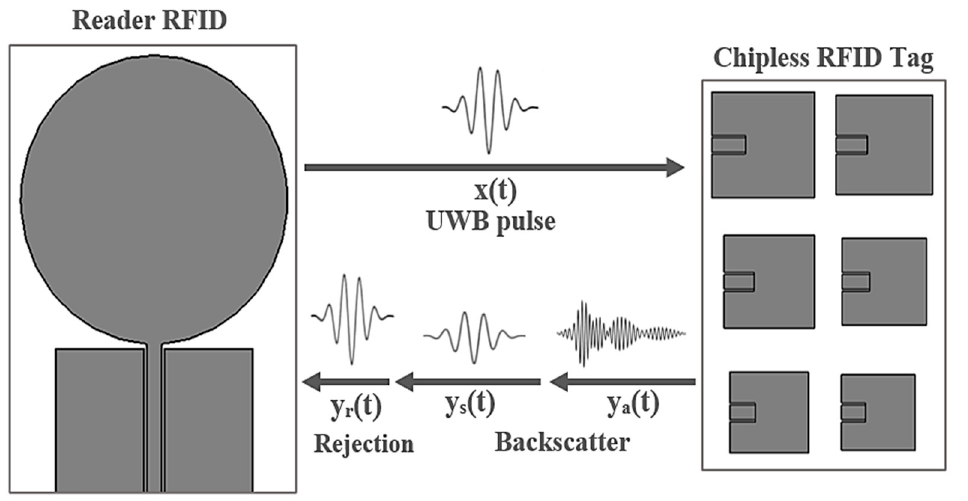
Figure 4. System model for the multipatch-based chipless RFID reader.